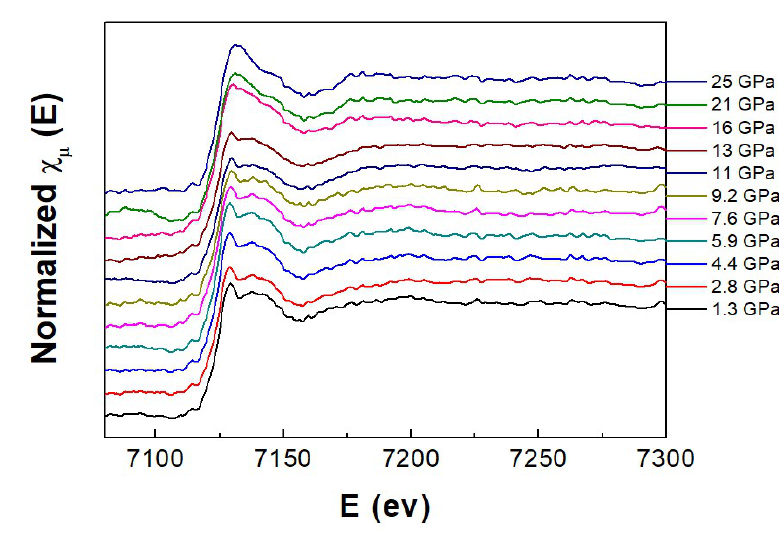
Figure 13. Pressure dependence of the x-ray absorption spectra of LuFe 2 O 4 obtained at the K -edge.